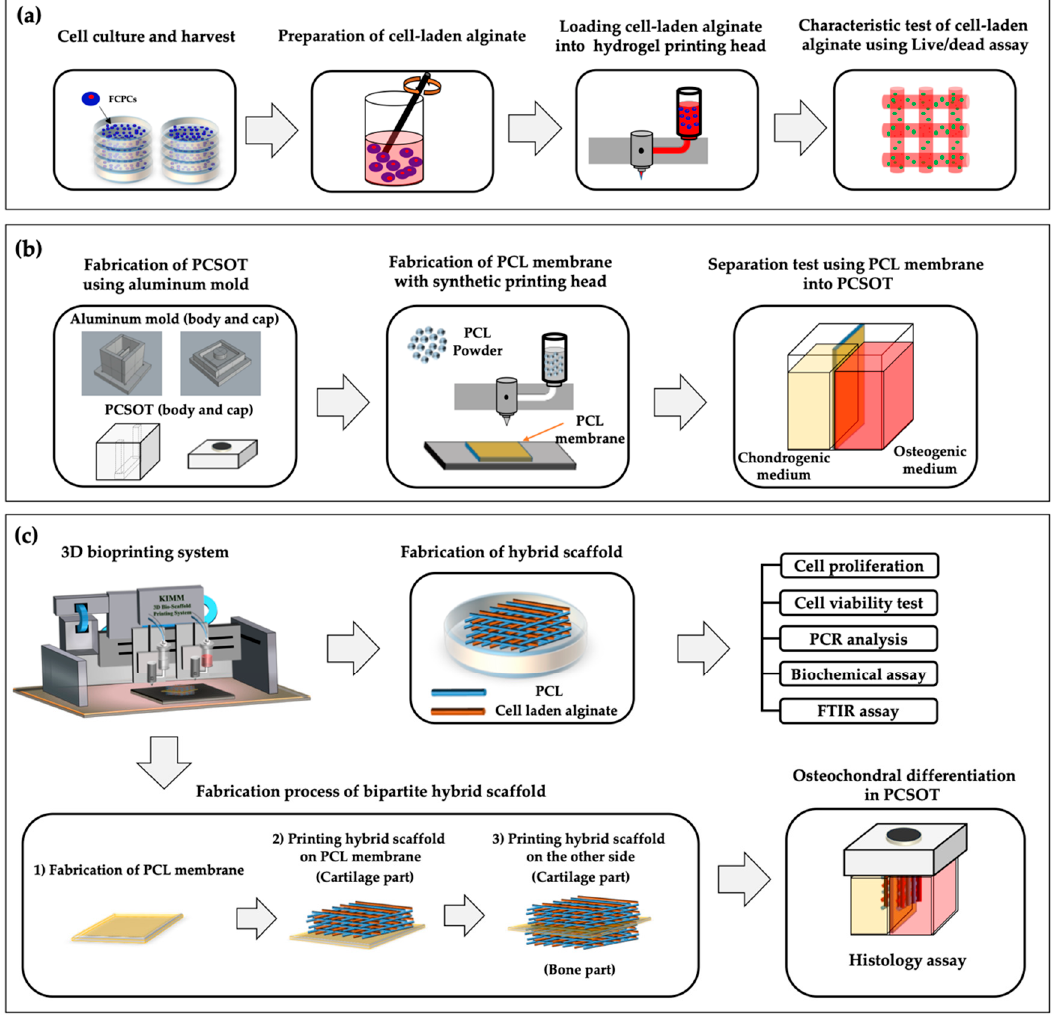
Figure 2. Schematics of the study flow. ( a ) FCPC culture and harvesting for analysis of the characteristics of 1%, 3%, and 5% (w/v) alginate. ( b ) PCSOT design and function test. ( c ) Bioprinted hybrid and bipartite hybrid scaffold; test of the biological performance. Cell-laden alginate was extruded between PCL lines.